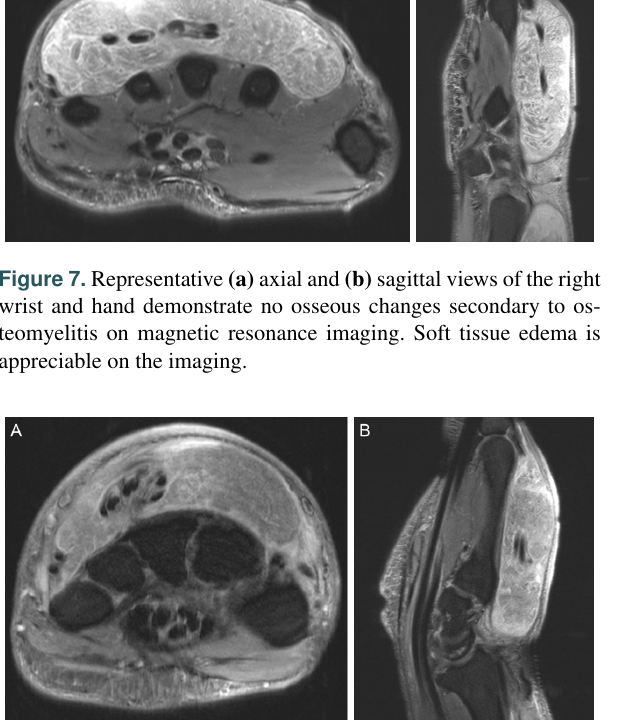
Figure 8. Representative (a) axial and (b) sagittal views of the left wrist and hand demonstrate no osseous changes secondary to os- teomyelitis on magnetic resonance imaging. Soft tissue edema is appreciable on the